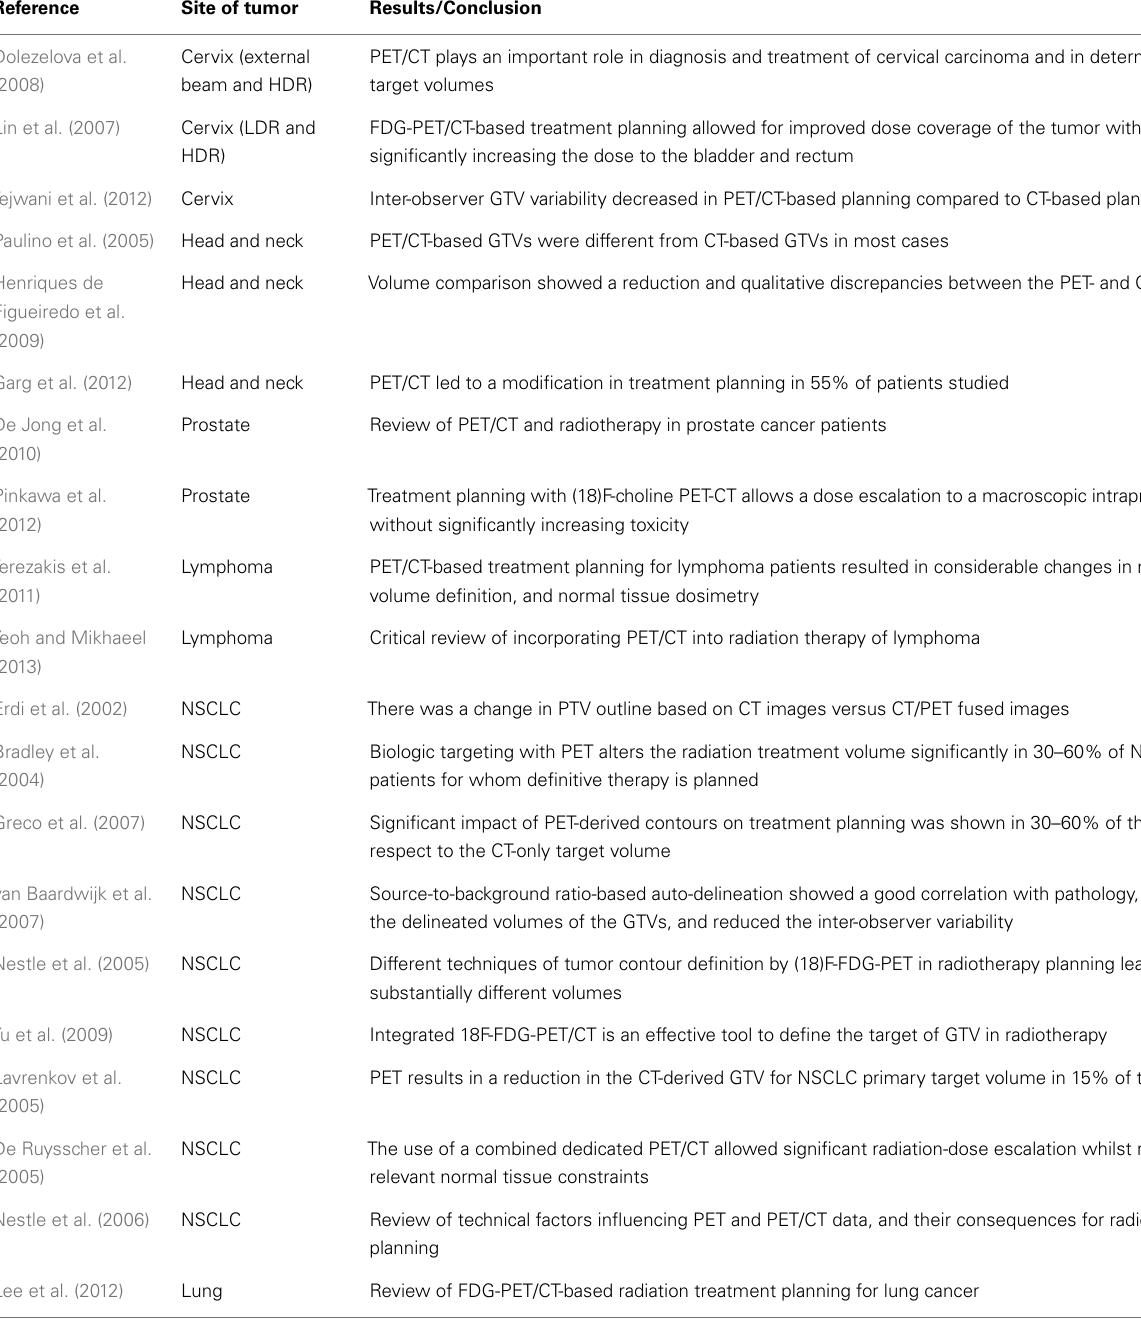
Table 1 |Application of PET/CT in radiation treatment